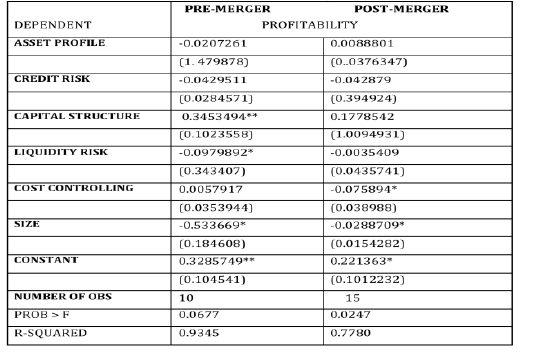
Table 2: Linear Regression of the Pre-Merger UBA and STB and the Post-Merger